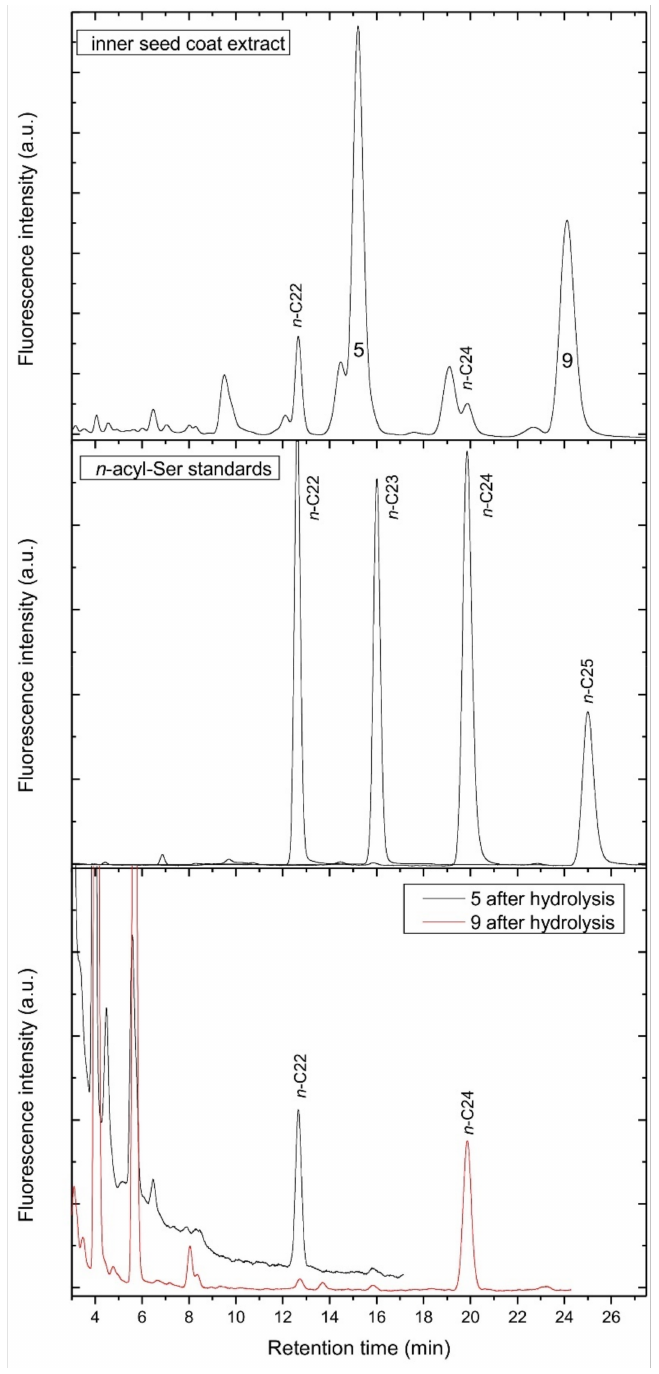
Figure 5. HPLC chromatograms of the inner seed coat extract of lemon ( top ), n -acyl-serotonin standards ( middle ) and acylserotonins obtained from fatty acids released from compounds 5 and 9 after acid hydrolysis ( bottom